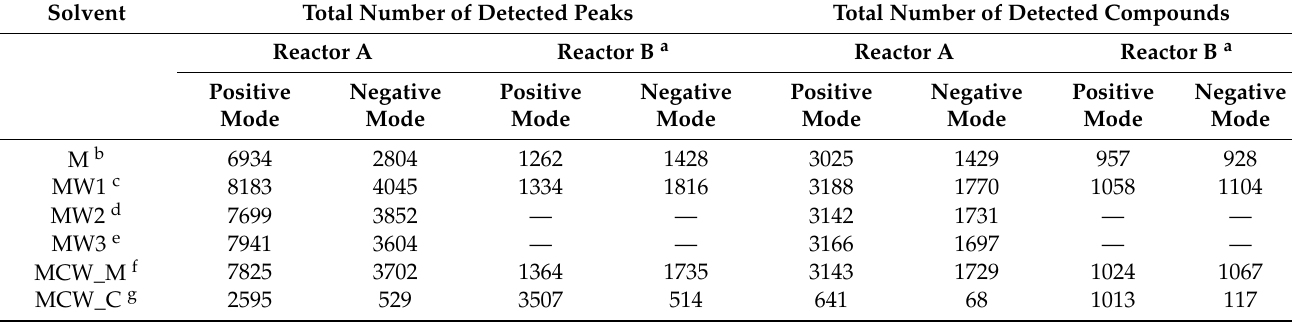
Table 2. Comparison of total detected peak numbers extracted from different solvent extraction methods (positive and negative mode) for Reactor A and Reactor